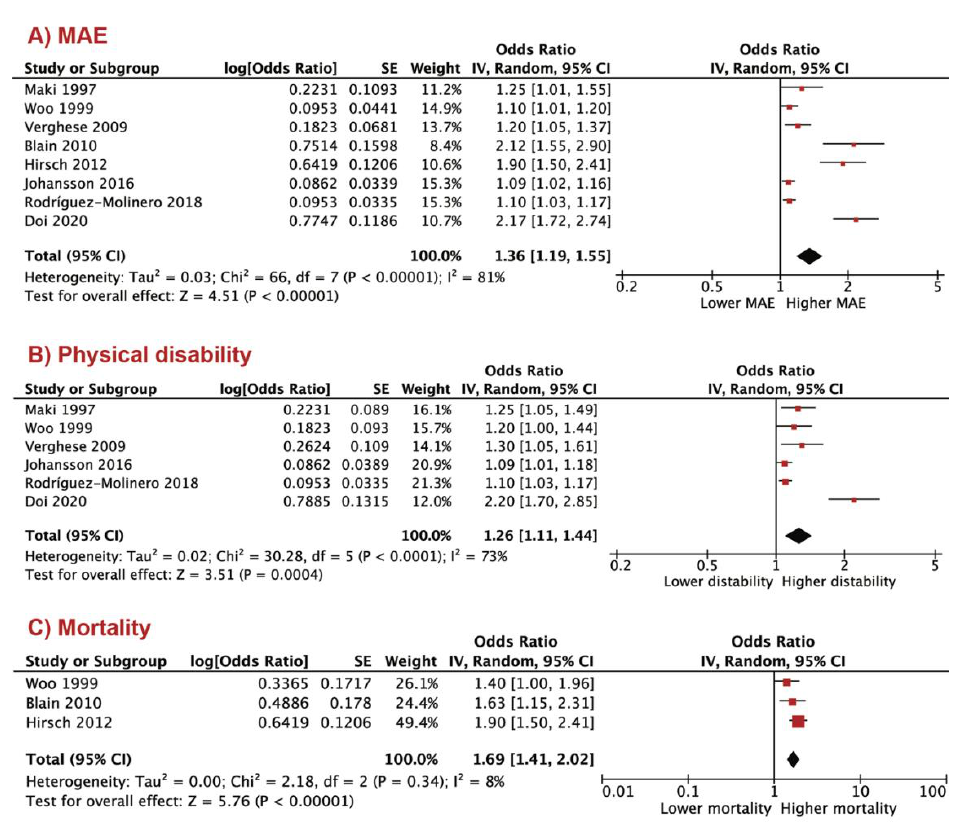
Figure 3. Shorter stride length in predicting adverse clinical events: ( A ) major adverse event (MAE); ( B ) physical disability; ( C ) mortality.